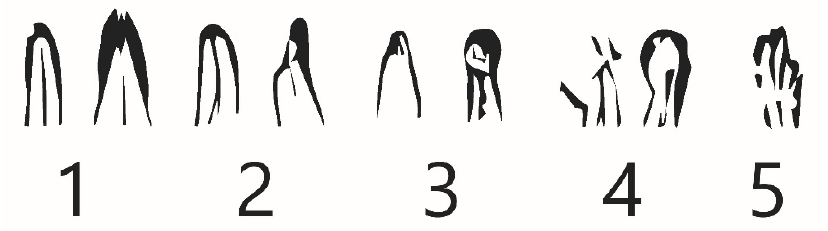
Figure 5. Periapical Index grading 1–5 scale (Ostravik 5-point scale).